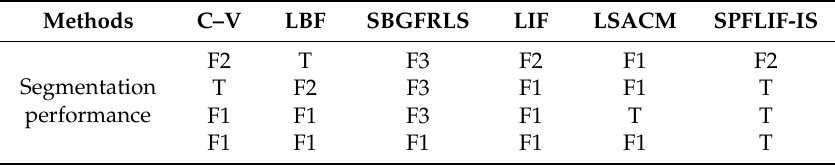
Table 2. Description of the segmentation results of Figure